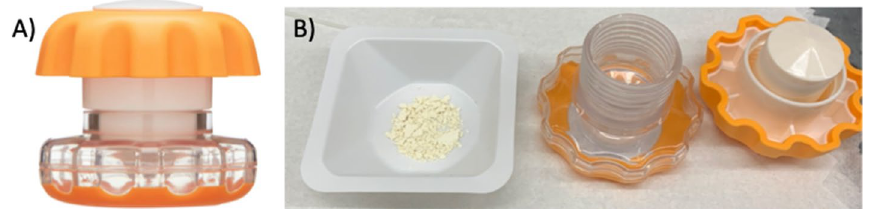
Fig. 1 Preparation of crushed Yomesan tablet for dissolution into Buffers. A Equate, Easy-Grip Pull Crusher, used to crush whole Yomesan (Niclosig and Lux) tablets. B 637.7 mg of a 500 mg niclosamide crushed Yomesan tablet (i.e., 0.784 mg niclosamide per 1 mg of